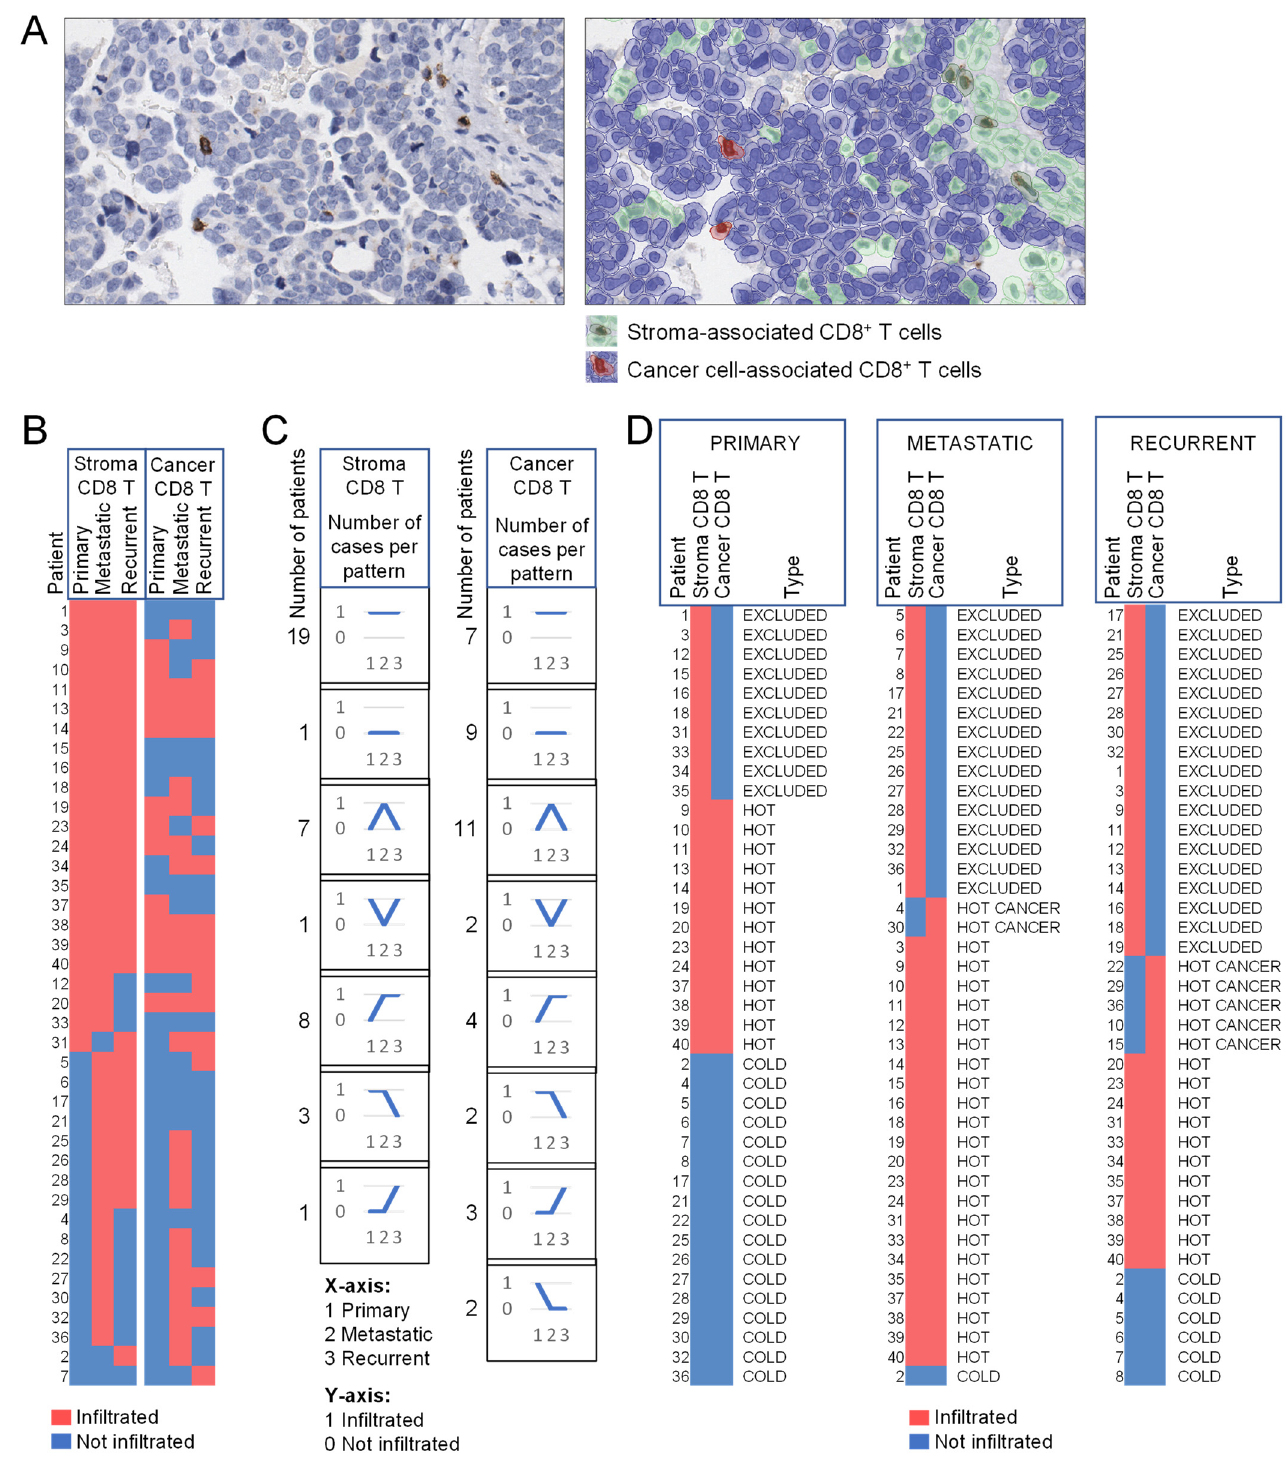
Figure 6. Compared to primary tumors, matched metastatic and recurrent tumors have an increased CD8 + T cell infiltration, however, CD8 + T cells are not necessarily reaching the tumor parenchyma. ( A ) Representative IHC staining with CD8 antibody (left panel) and QuPath annotation of the stroma- and cancer cell-associated CD8 + T cells (right panel). ( B ) Topography of stroma- and cancer cell-associated CD8 + T cells in matched primary, metastatic, and recurrent tumors from 40 HGSOC patients. An arbitrary threshold of 2% of CD8 + T cells was used to assign the ‘infiltrated’ or ‘not infiltrated’ phenotype. ( C ) Quantification of the same patients with different patterns of the ‘infiltrated’ and ‘not infiltrated’ phenotype in the stroma and cancer cell area across patient-matched primary, metastatic, and recurrent tumors. The patterns of immune infiltration are represented by